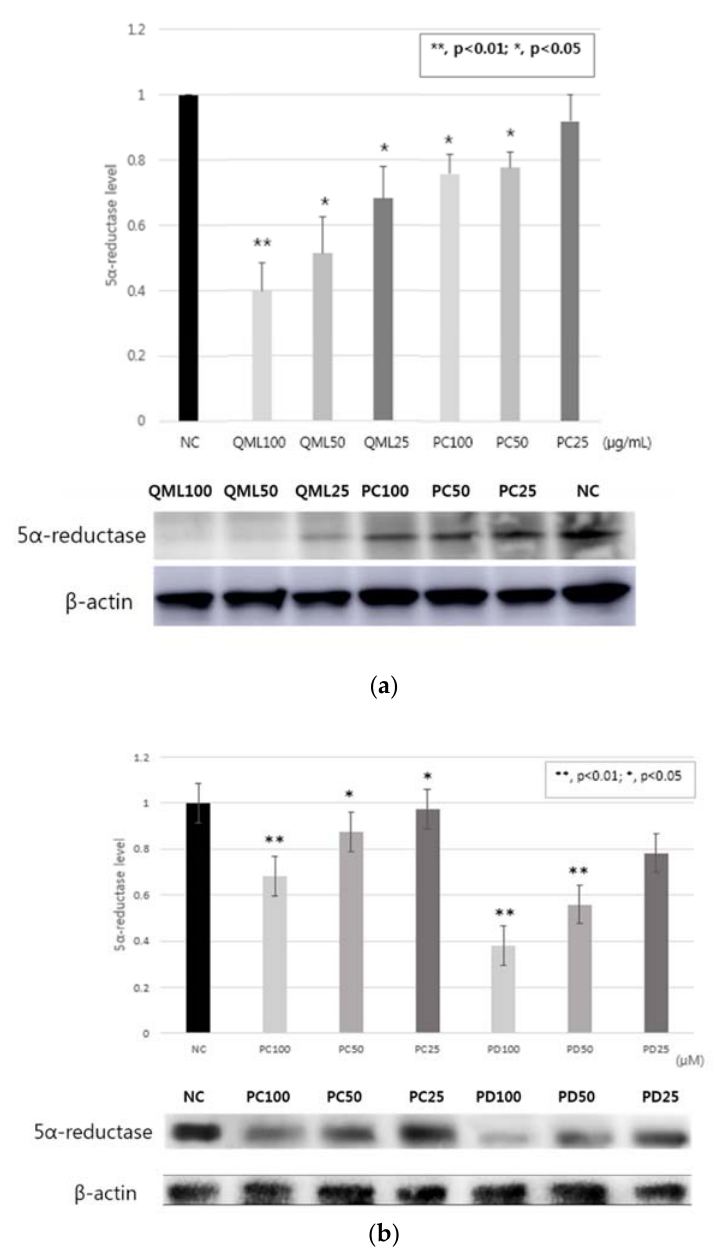
Figure 1. 5 α -reductase type 1 inhibitory activity in HaCaT cell. ( a ) QML; ( b ) PD. Data are expressed as the means ± standard deviation (SD) of three determinations. * p < 0.05; ** p < 0.01, compared with normal control. NC: normal control; PC: positive control.